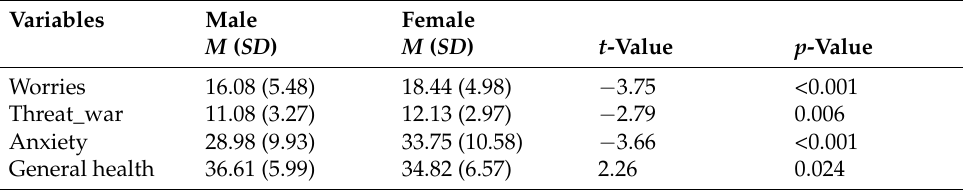
Table 1. Gender differences in the main study variables.